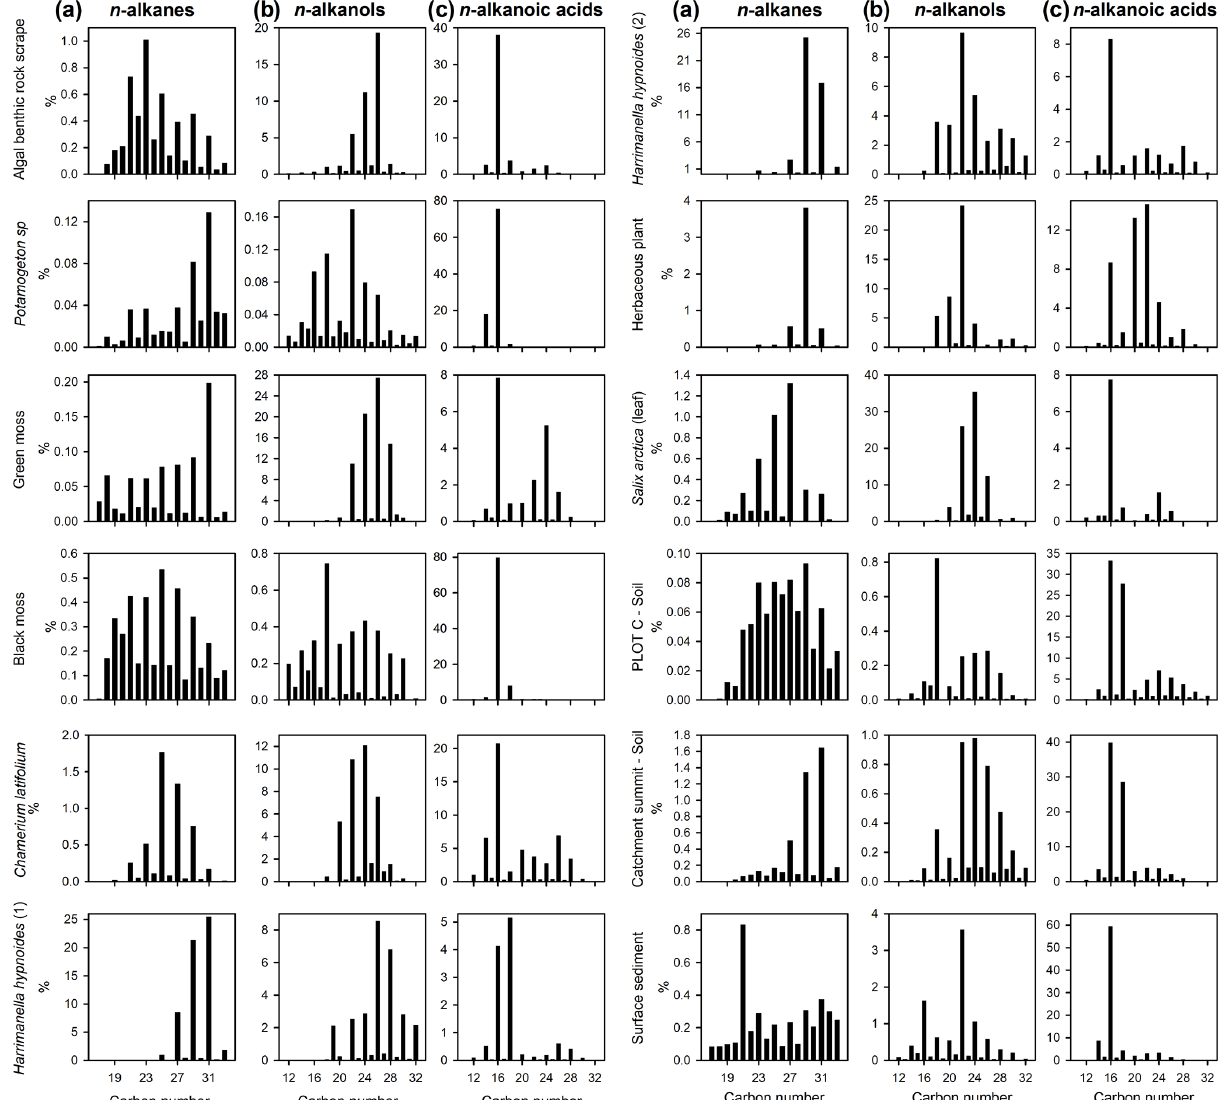
Figure 5. Lipid distribution histograms for (a) n -alkanes, (b) n -alkanols and (c) n -alkanoic acids for catchment plant, soil and surface sediment samples from Disko 2 lake and catchment analysed using GC–MS. Expressed as the relative proportion of total saturated n - alkanes, n -alkanols and n -alkanoic acids. Soil samples are taken from close to the Disko 2 shoreline (plot C) and close to the highest point in the catchment at 893m (catchment summit). Locations detailed in Stevenson (2017). Numbers (1) and (2) indicate replicates of separate samples from the Disko 2 catchment with the same